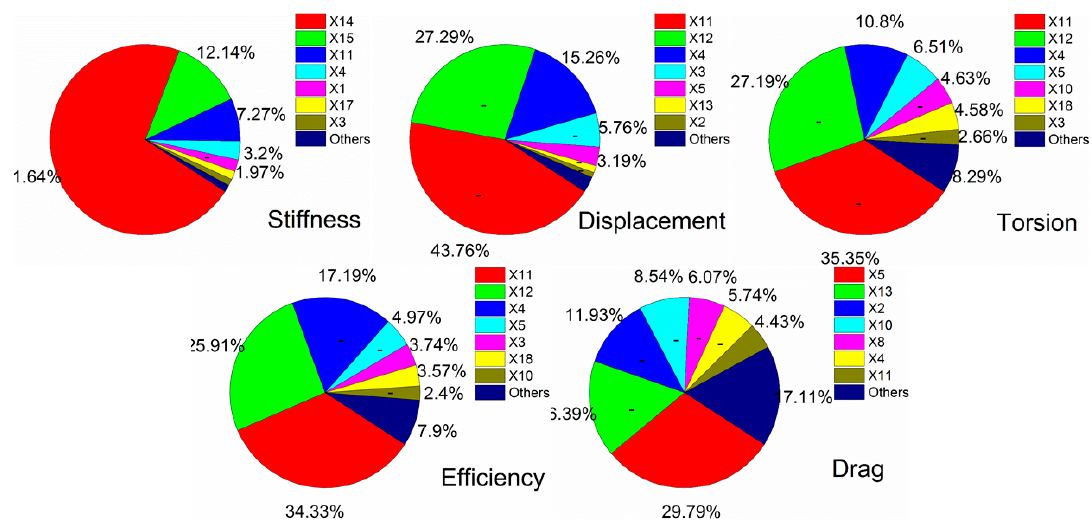
Figure 11. Sensitivity of the optimal design obtained by the GP method.